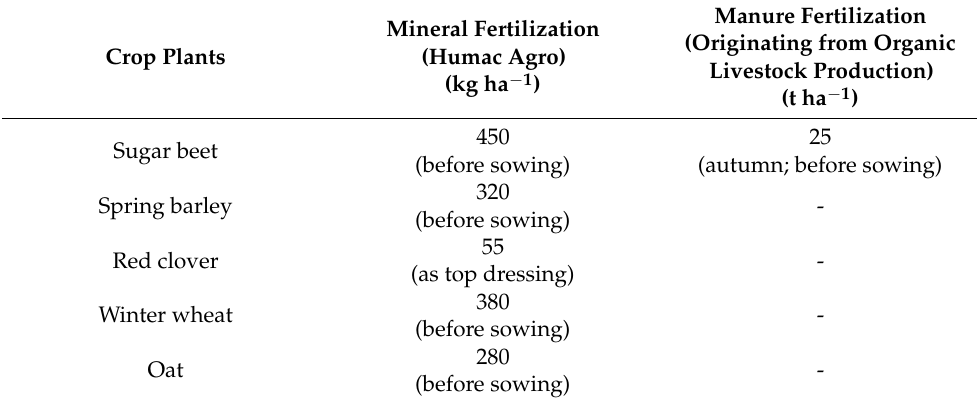
Manure Fertilization (Originating from Organic